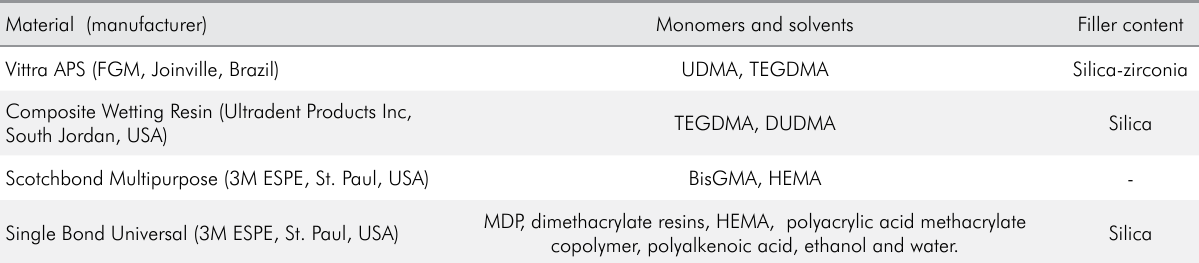
Table 1. Description of the evaluated materials. Material